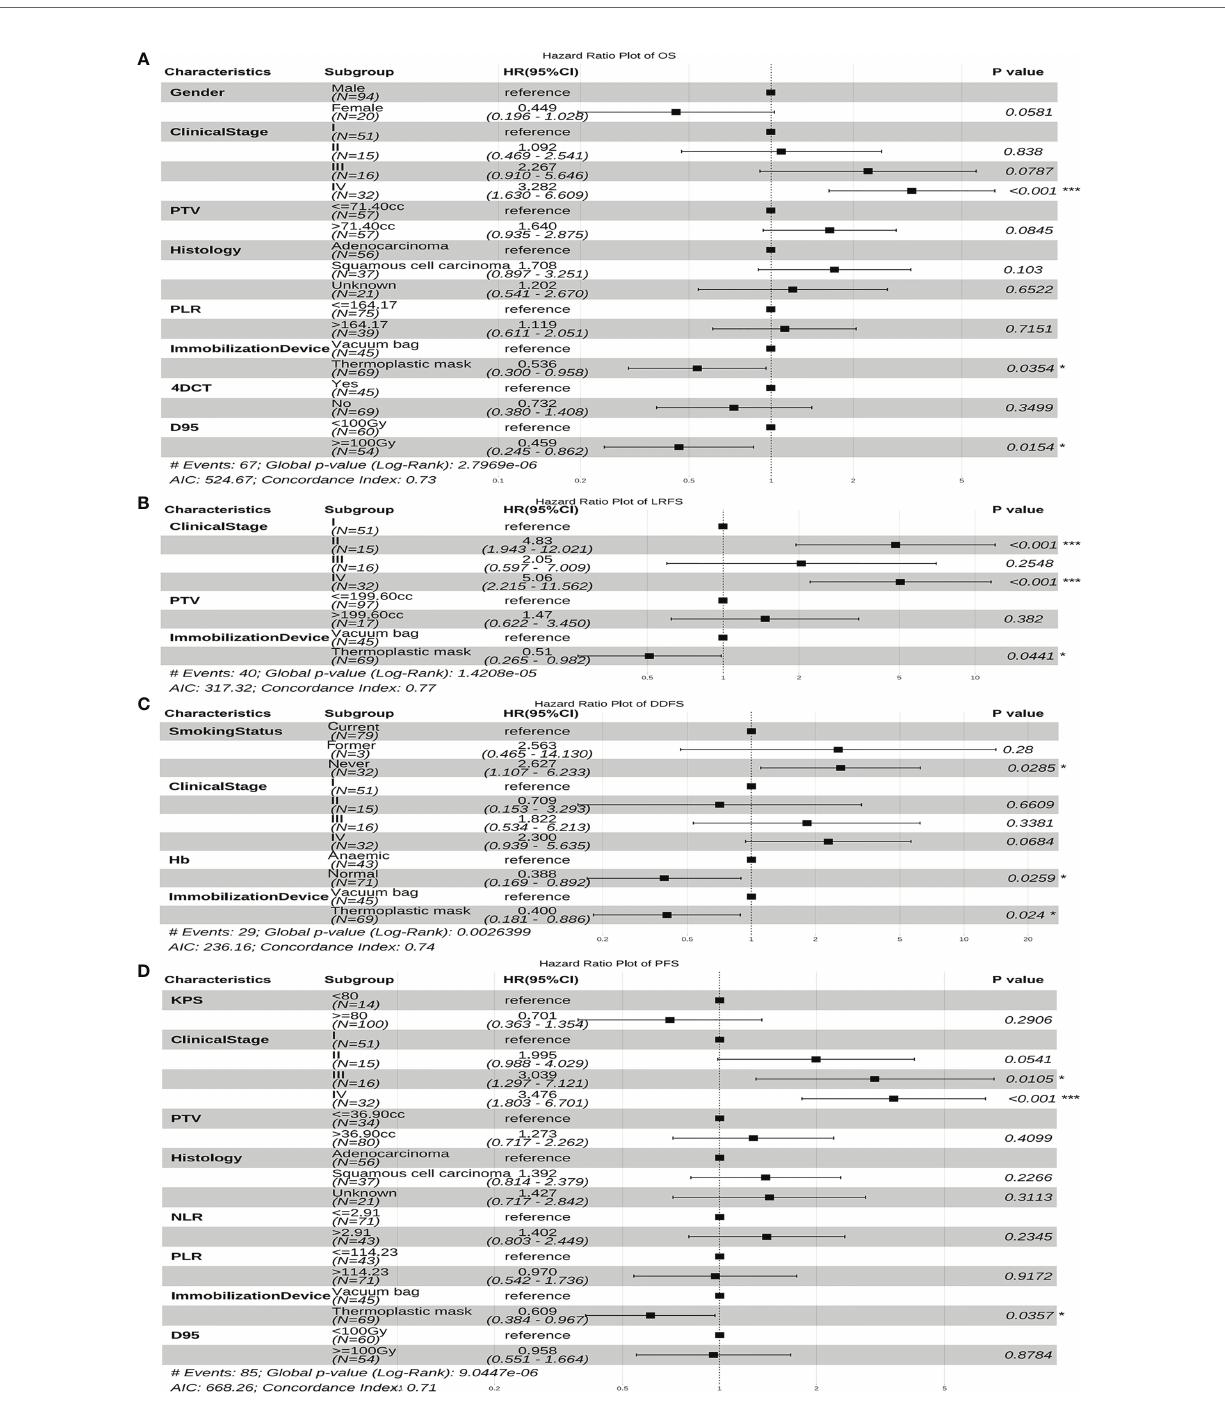
FIGURE 4 | The forest plot of the multivariate cox regression analyses of risk factors for OS (A) , LRFS (B) , DDFS (C) and PFS (D) . *p-value < 0.05, ***p-value < 0.001. PTV, planning target volume; Hb, hemoglobin; NLR, Neutrophil-to-Lymphocyte ratio; PLR, Platelet-to-Lymphocyte ratio; 4DCT, four-dimensional computed tomography; D, the prescription dose covers 95% of the target area; OS, overall survival; LRFS, local recurrence free survival; DDFS, distant disease-free survival; PFS, progression free survival; HR, hazard ratio; CI, con fi dence